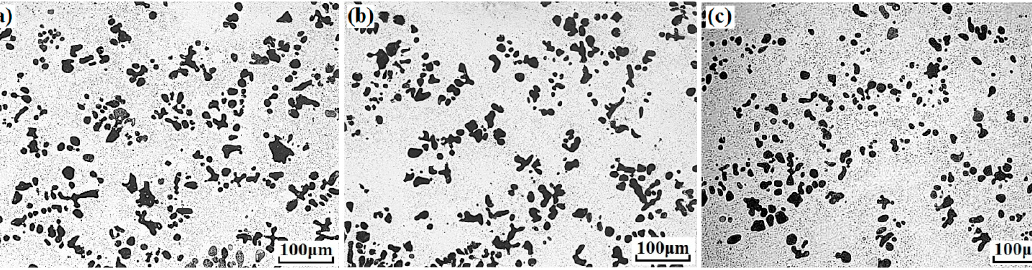
Figure 2. Microstructures of alloys solidified with alternating magnetic field (AMF): ( a ) Cu–14Fe–0.1Ag; ( b ) Cu–14Fe–0.5Ag; ( c ) Cu–14Fe–1Ag.